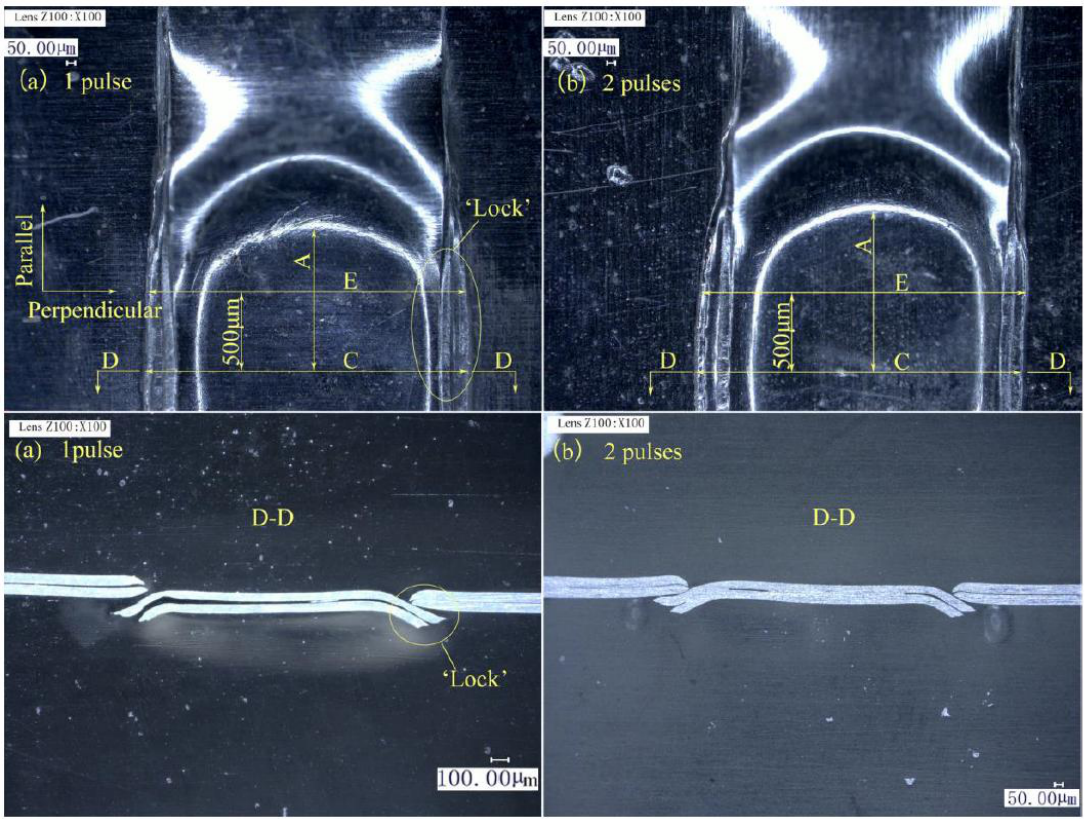
Figure 9. Lower foil side view and D-D section of joints with two different number of laser pulses on the lower foil side: ( a ) 1 pulse; ( b ) 2 pulses.